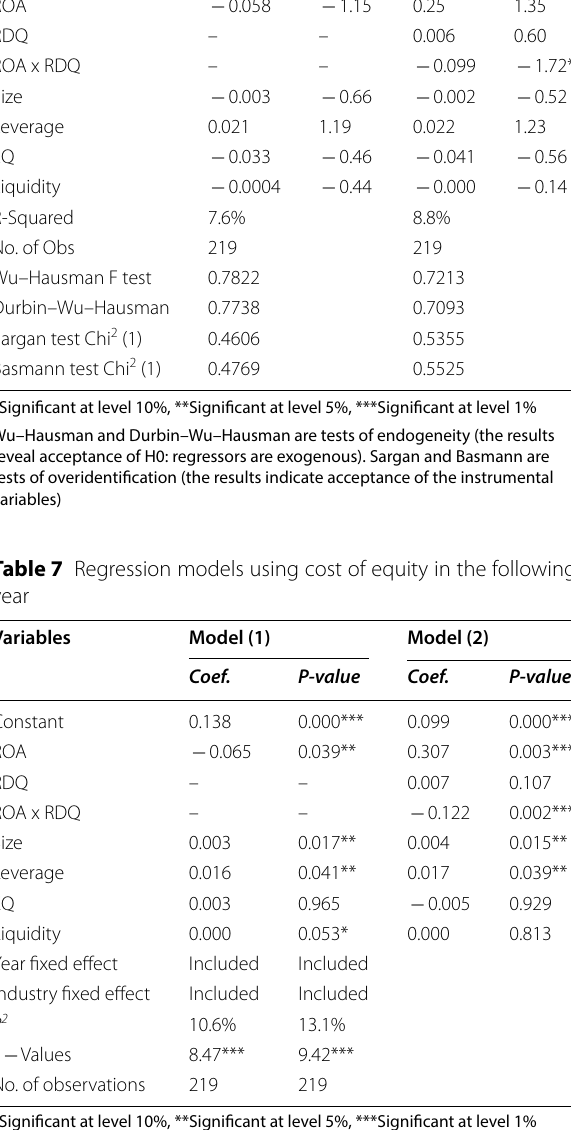
No serious multicollinearity in both models